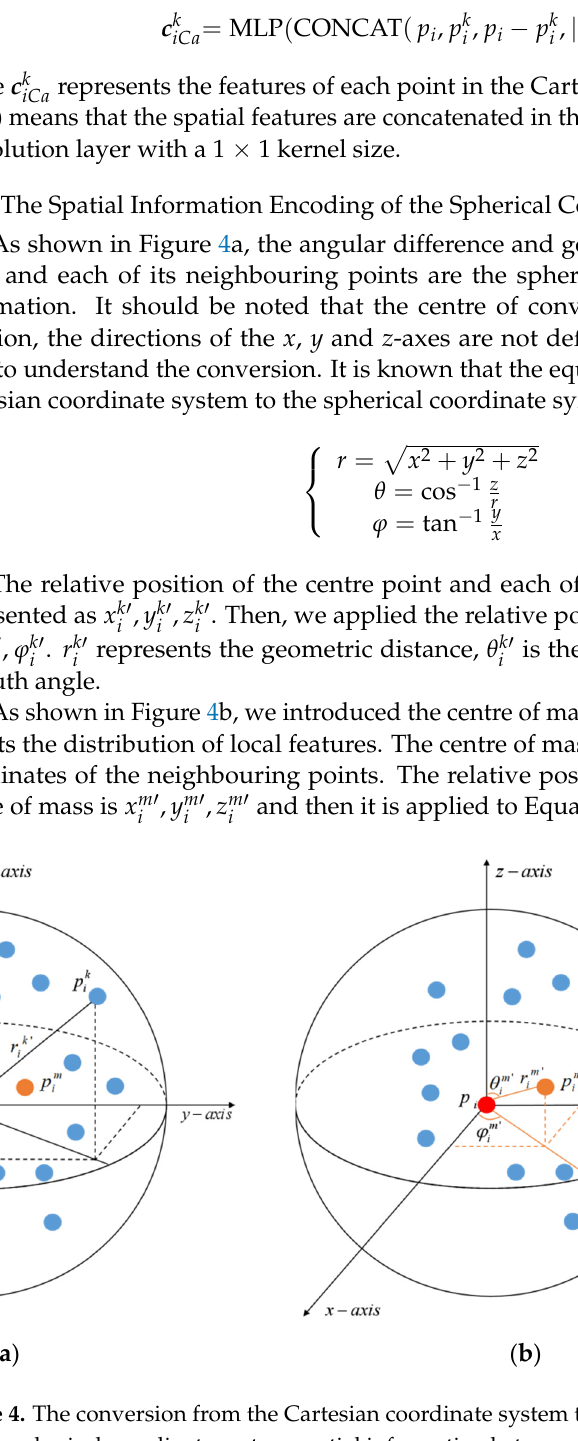
Figure 3. The architecture of the MSI block.